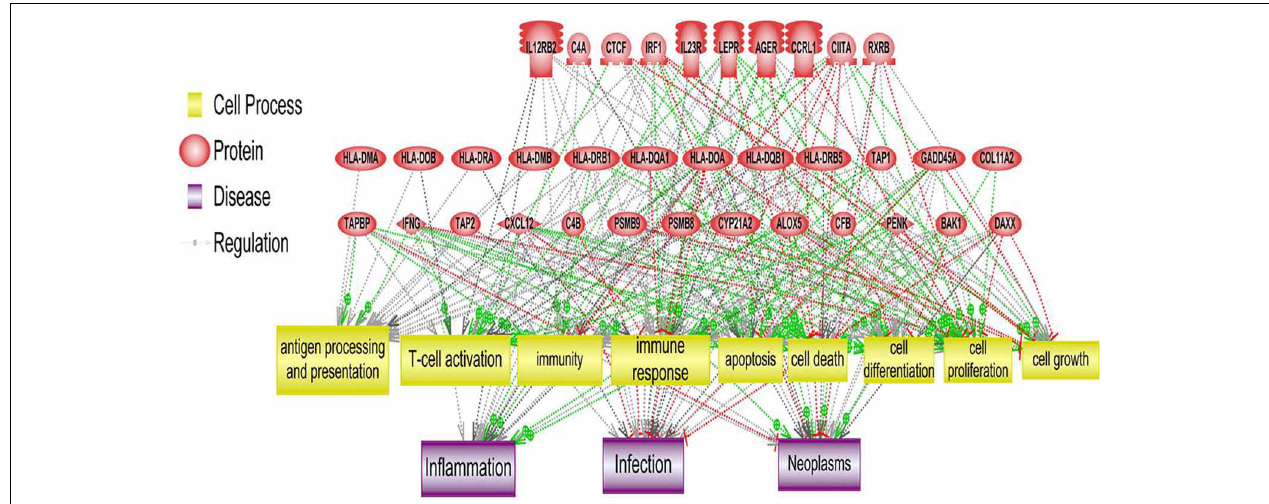
FIGURE 4 | Systems biology analysis of amplified and deleted cytoband regions. Downstream analysis of genes located on cytobands with significantly abnormal CIN index in cohort of patients with relapse shown.